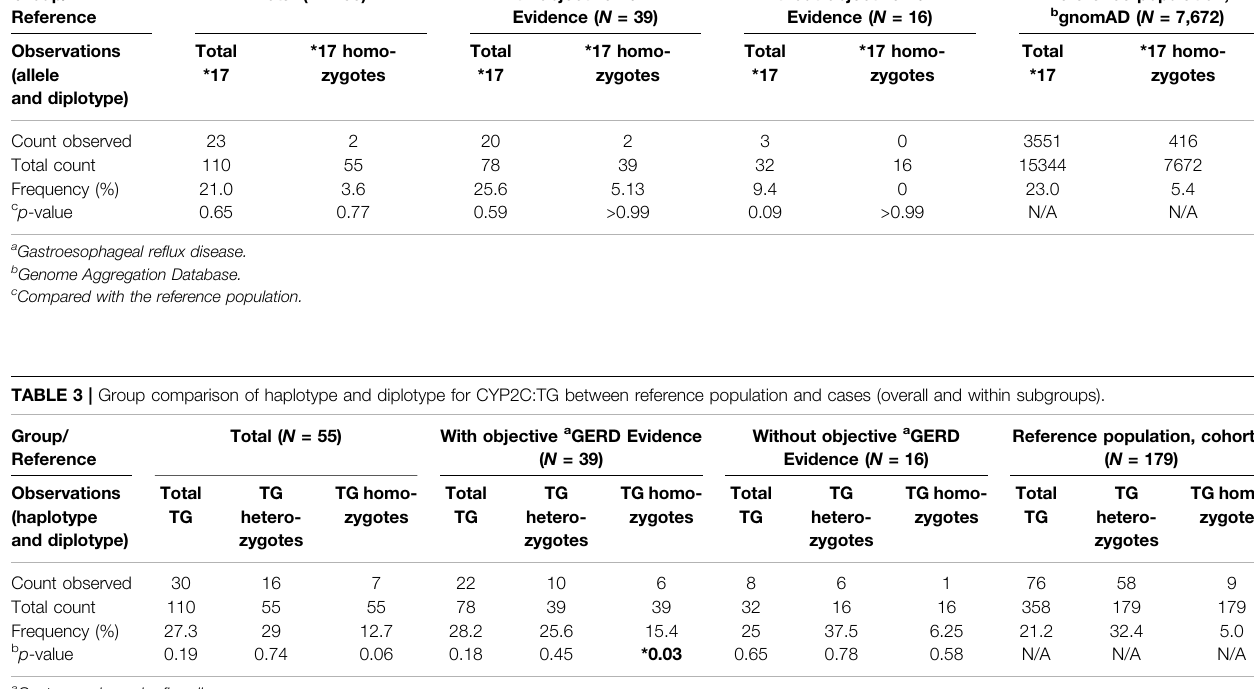
( Supplementary Table S5 ). Out of the seven identi fi ed CYP2C:TG homozygotes, all were inferred to be normal metabolizers except for one case, who was a CYP2C19*4 heterozygote, leading to assignment of an intermediate metabolizer phenotype. Four out of the 16 CYP2C:TG heterozygotes were found with one non- functioning CYP2C19*2 allele.